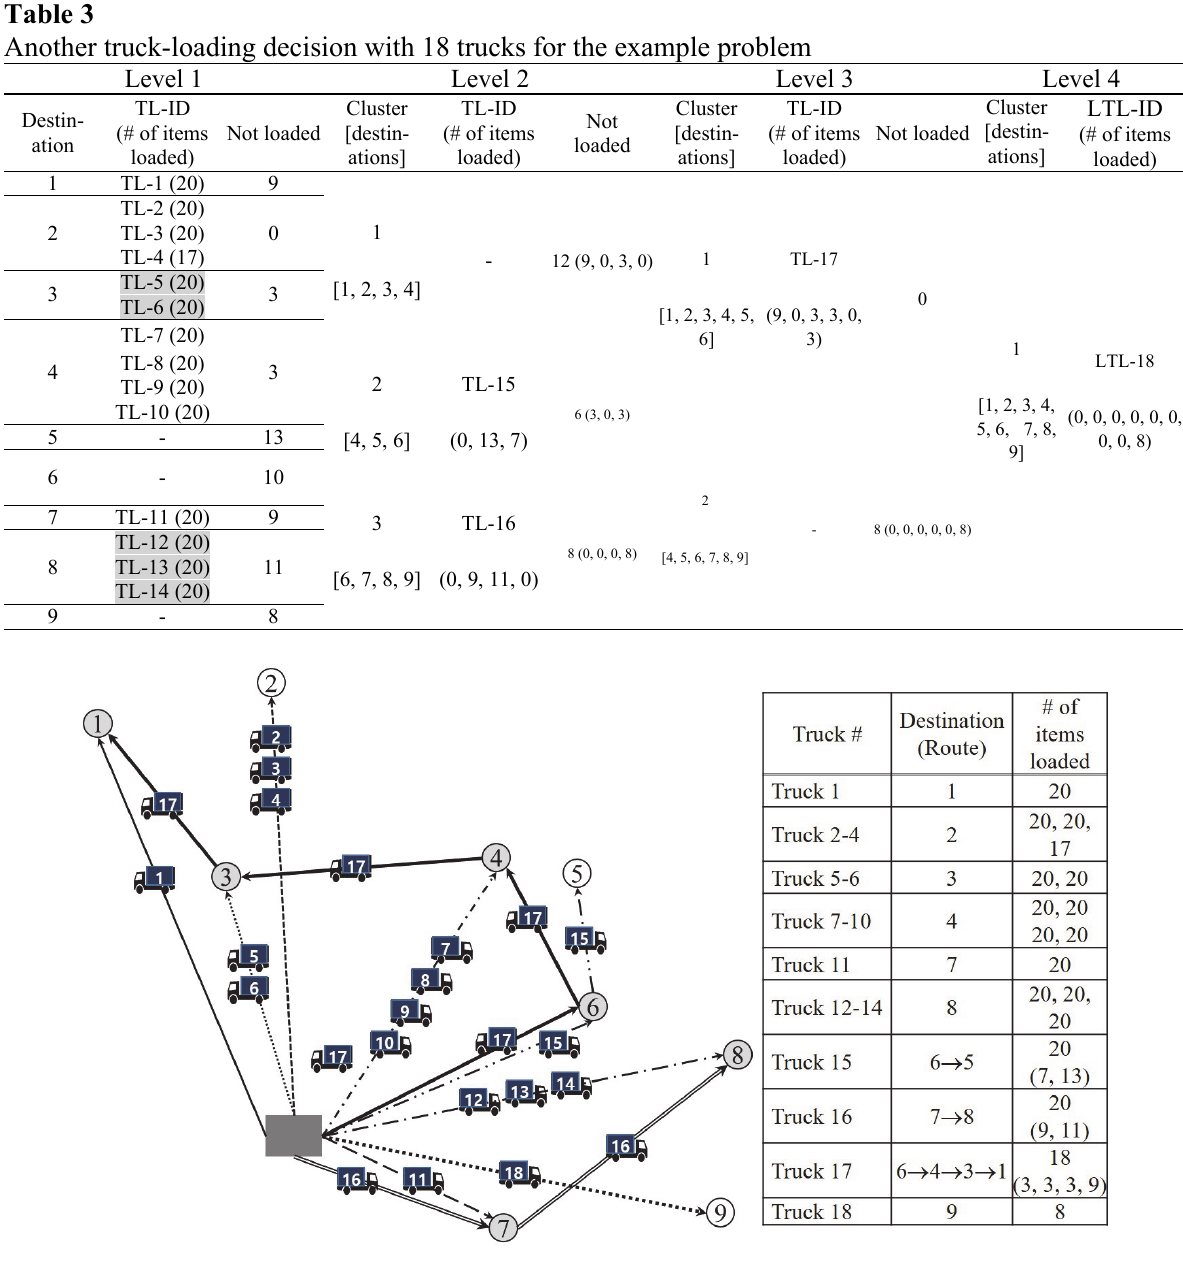
Fig. 3. Graphical representation of sequential batching for results shown in Table